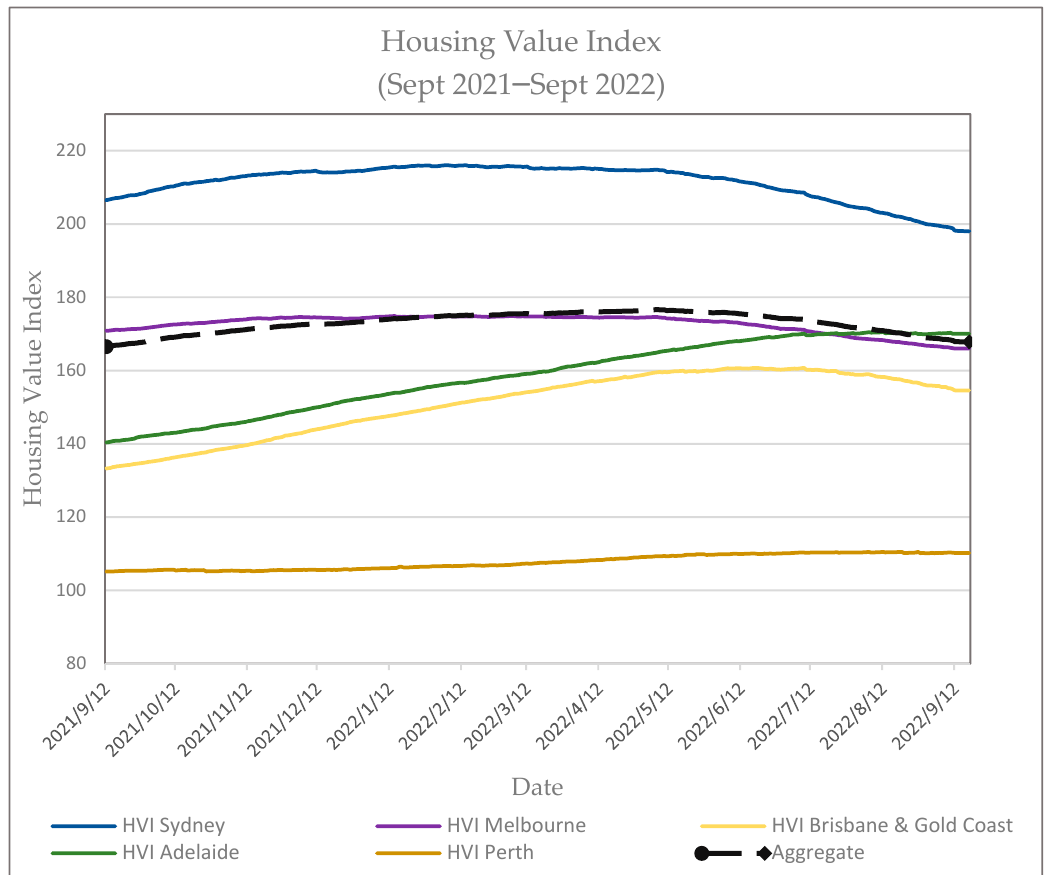
Figure 5. Housing Value Index for the national aggregate, Sydney, Melbourne, Brisbane and Gold Coast, Adelaide and Perth.